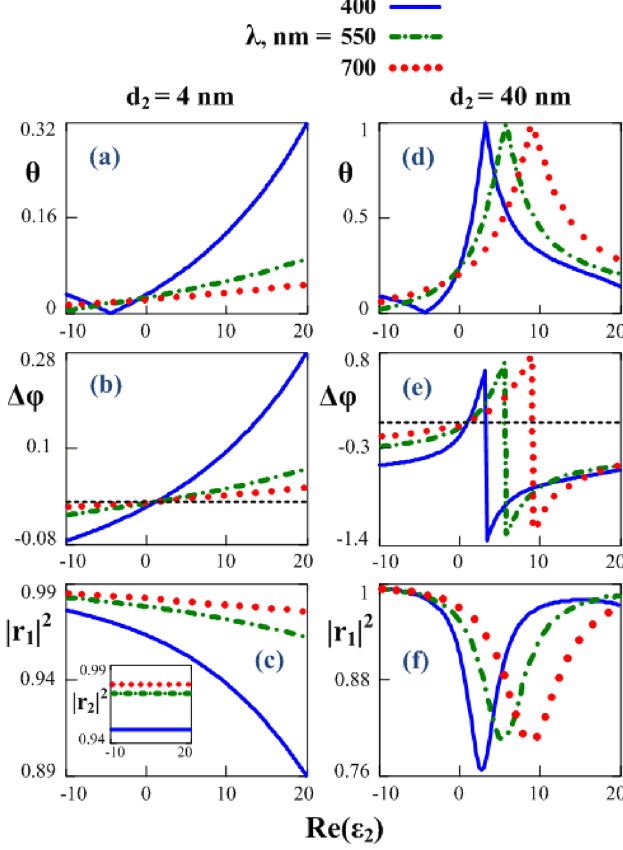
Fig. 7. Dependences of angle u (a, d), PSD of the re fl ected waves (b, e) and corresponding energy re fl ection coef fi cients (c, f) on parameter e 0 2 for various wavelengths of the incident wave. The values of parameters are: d 2 =4nm (a – c), 40nm (d – f). The values of parameters for all the graphs are: c =0, d 1,3,4 =0, e 00 2 ¼ 0 : 1 , m 2 = 1, the substrate material is silver. The inset in characterizes the energy re fl ection coef fi cient for the substrate corresponding to the data in c, f. The black horizontal dashed line in b, e corresponds to the condition D ’ = 0. Parameter e 0 2 is used as the abscissa axis for all the